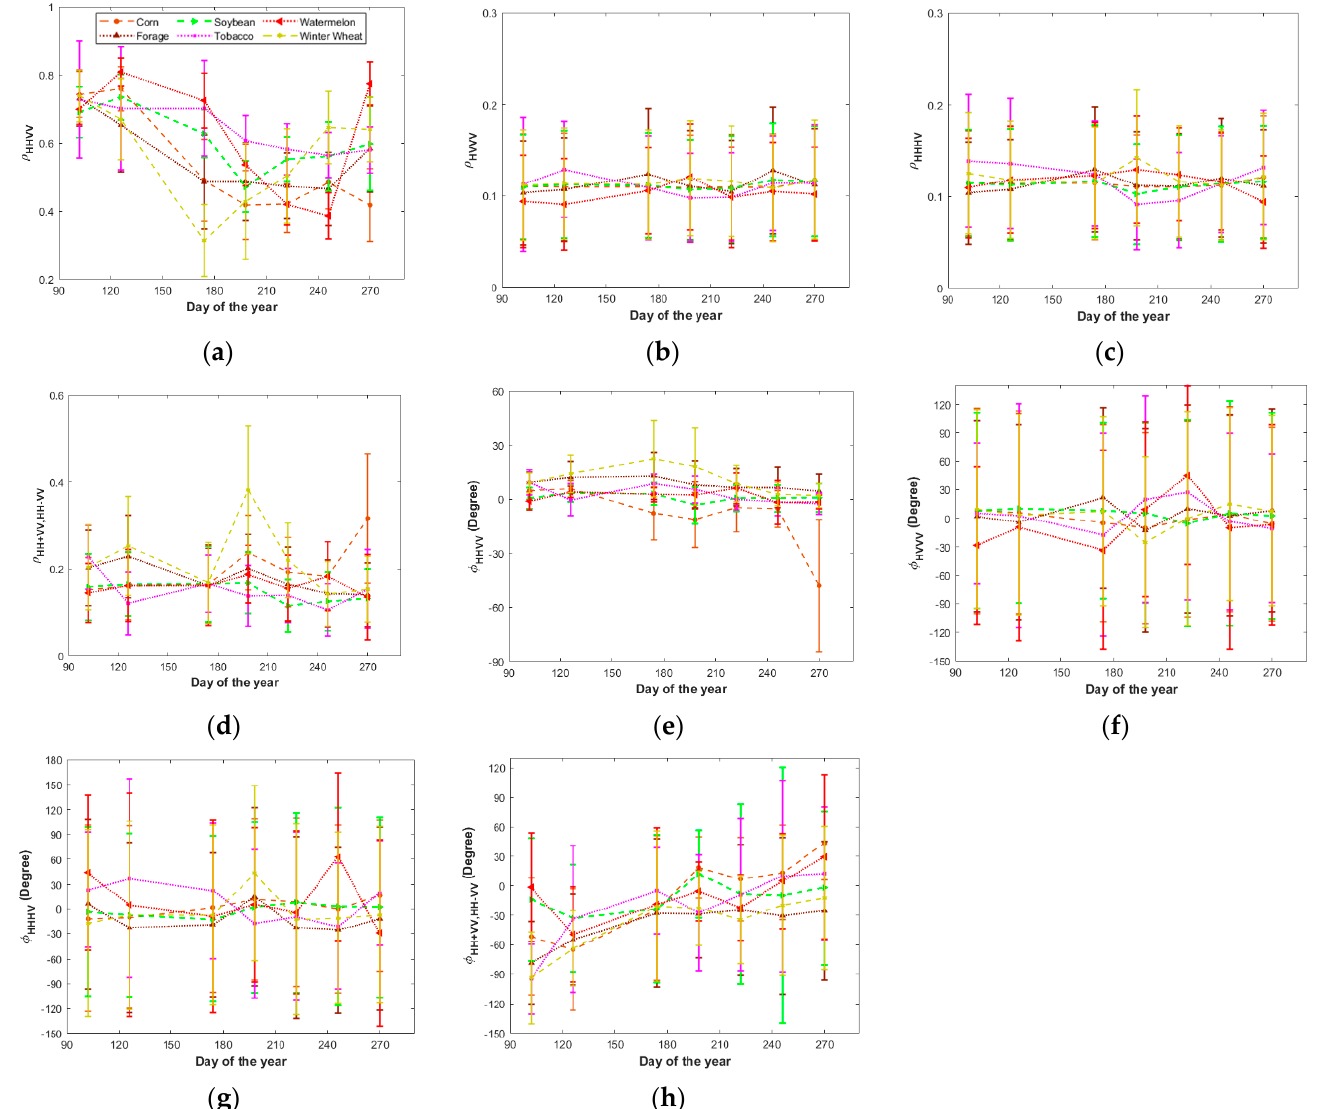
Figure 7. Temporal evolutions in correlation coefficients, phase differences and radar vegetation indexes (RVIs) for crops. ( a ) ρ HHVV ; ( b ) ρ HVVV ; ( c ) ρ HHHV ; ( d ) ρ HH + VV , HH − VV ; ( e ) φ HHVV ; ( f ) φ HVVV ; ( g ) φ HHHV ; ( h ) φ HH + VV , HH − VV . Note error bars denote standard